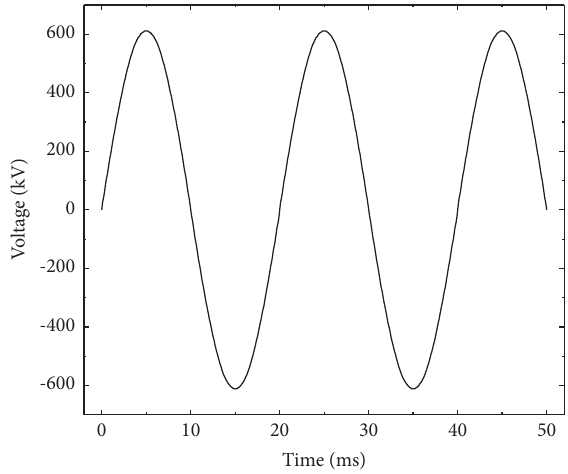
Figure 6: The voltage in the time domain.